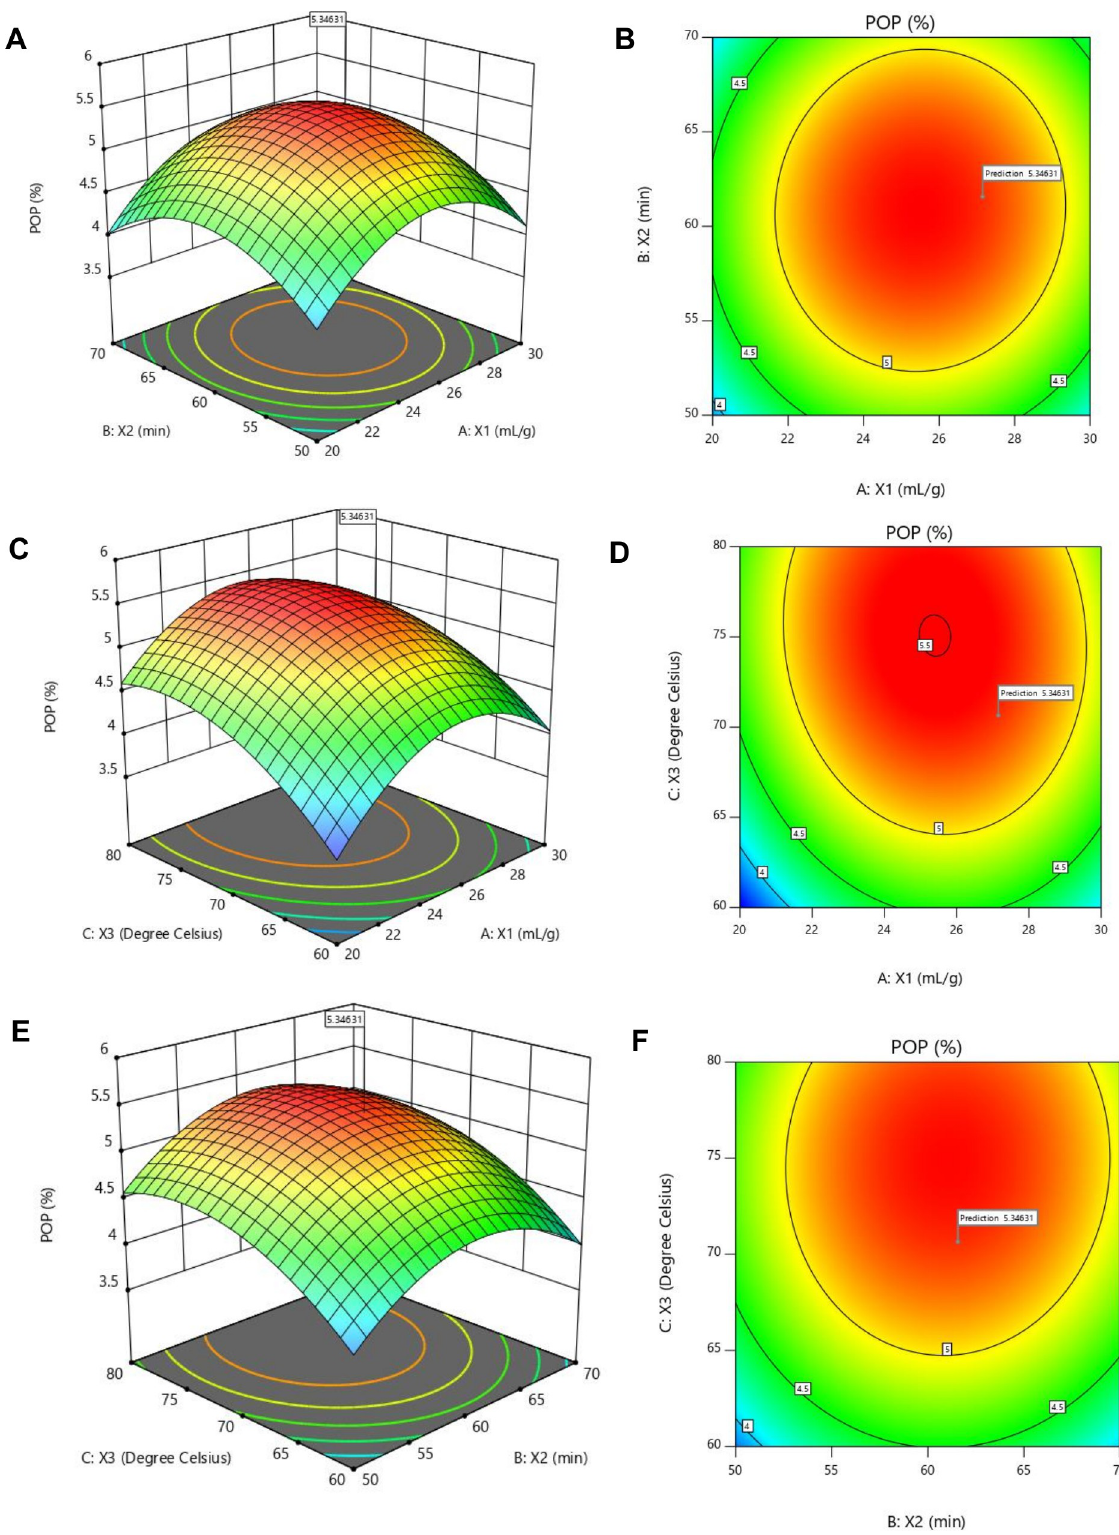
Fig 2. Response surface and contour plots for % yield of POP from Pleurotus ostreatus (Jacq.) P. Kumm. (A-B) Water to raw materials and extraction time (C-D) Water to raw materials and extraction temperature and (E-F) Extraction time and extraction temperature.